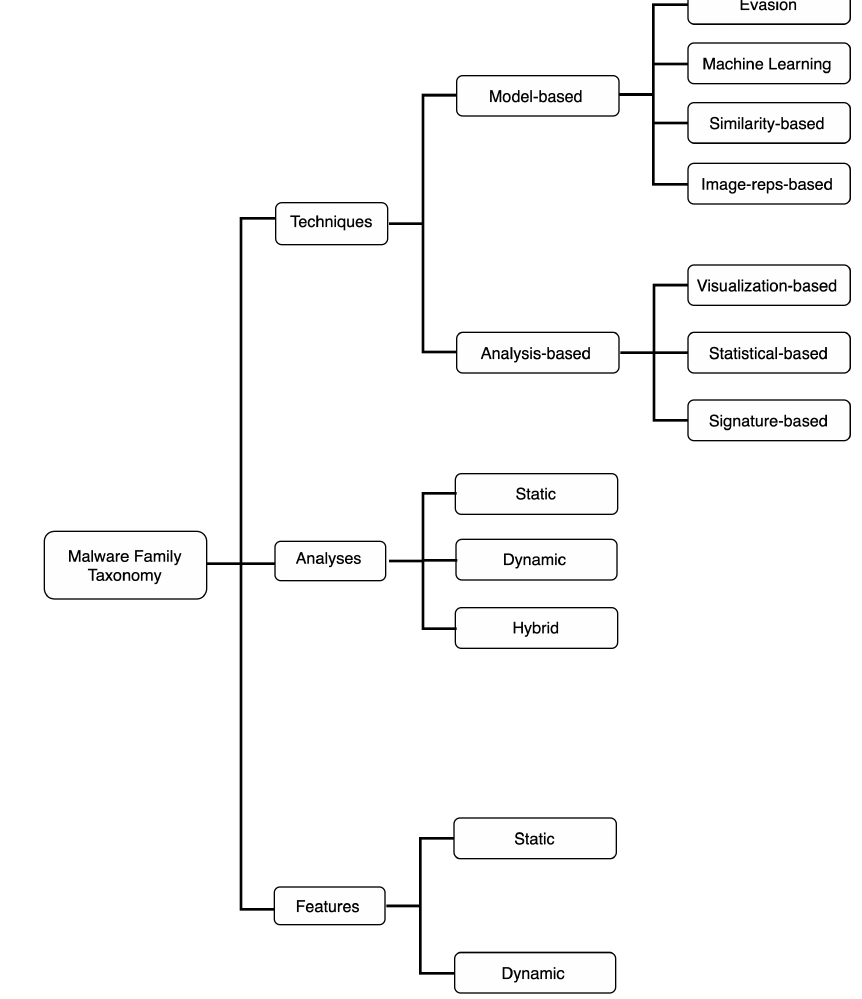
Figure 1. Android malware families